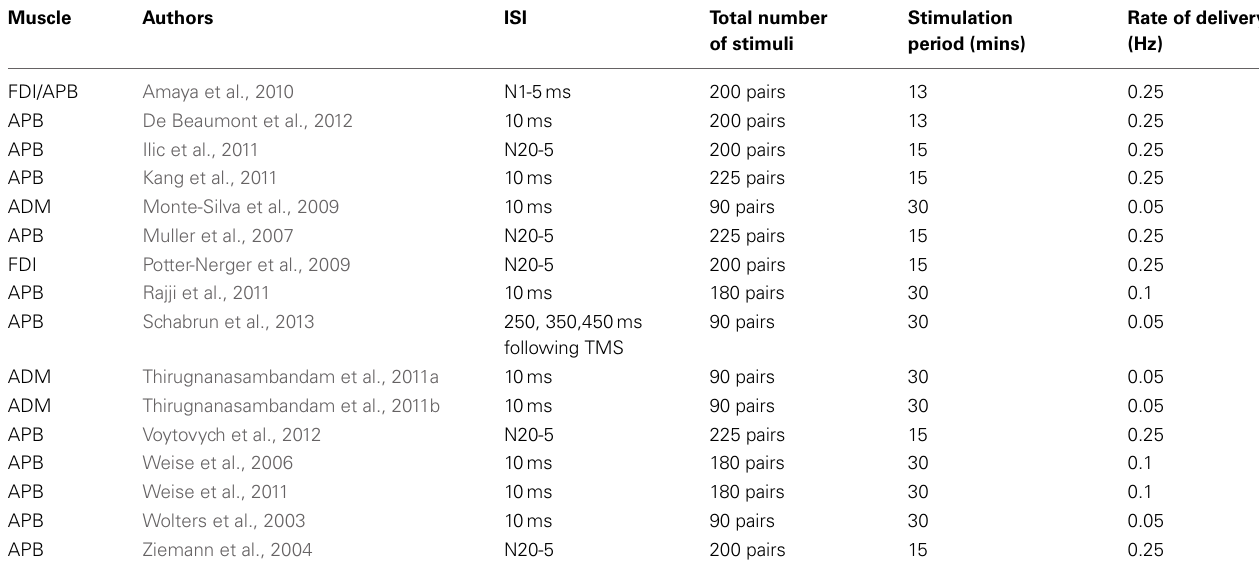
Table 2 | Upper limb muscles: inhibitory effects.